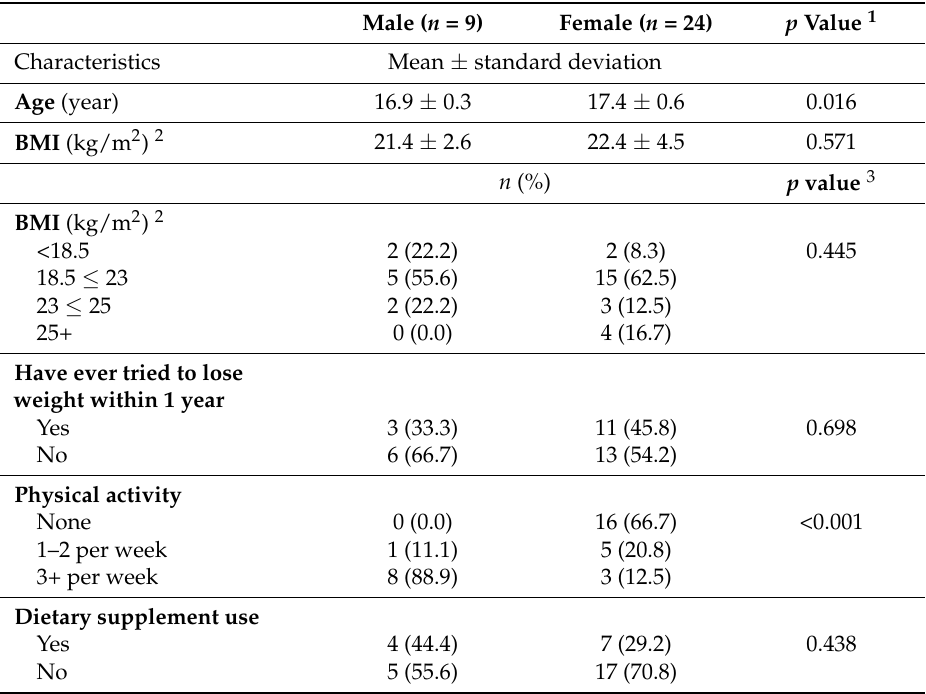
Table 1. Baseline characteristics of adolescents enrolled in an intervention study of mobile application, Diet-A ( n = 33).